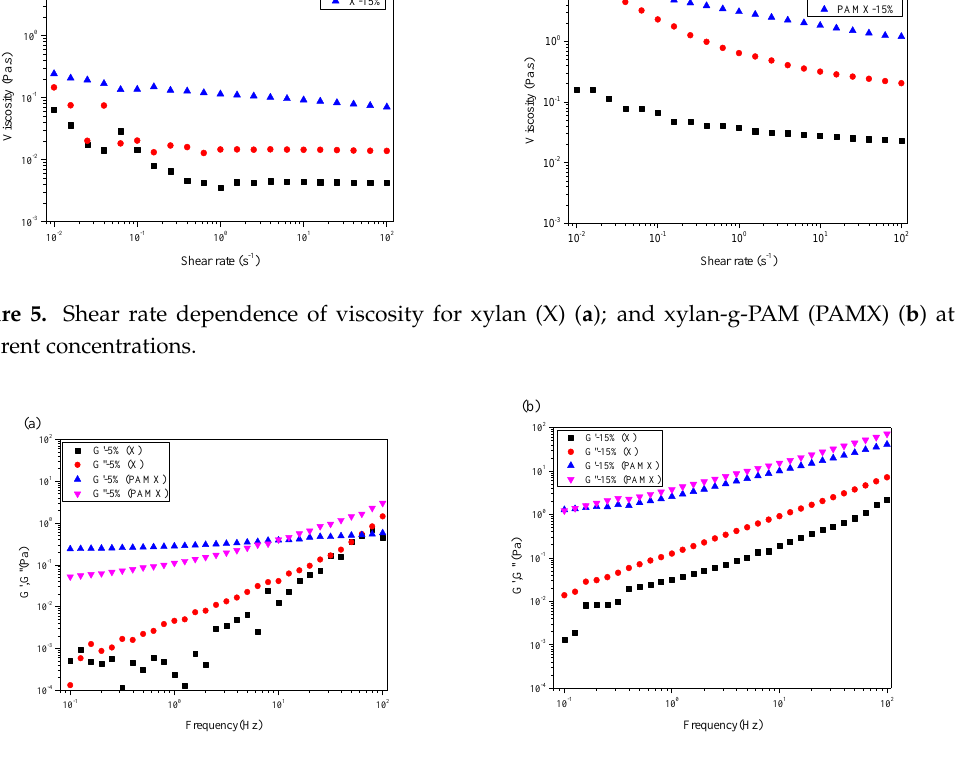
Figure 6. Frequency dependent modulus of the solutions of xylan (X) and xylan-g-PAM (PAMX) at 5% concentration ( a ); at 15% concentration ( b ).